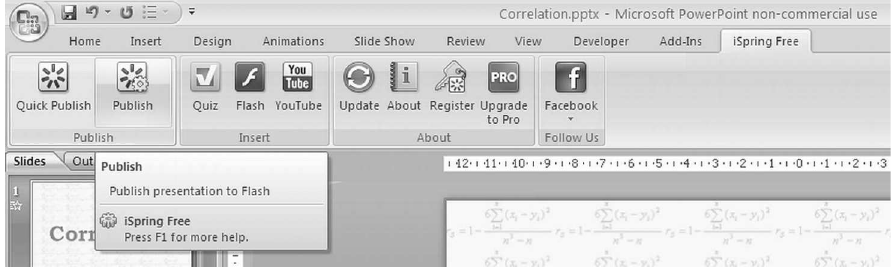
Figure 3. iSpring Free options available on the PowerPoint